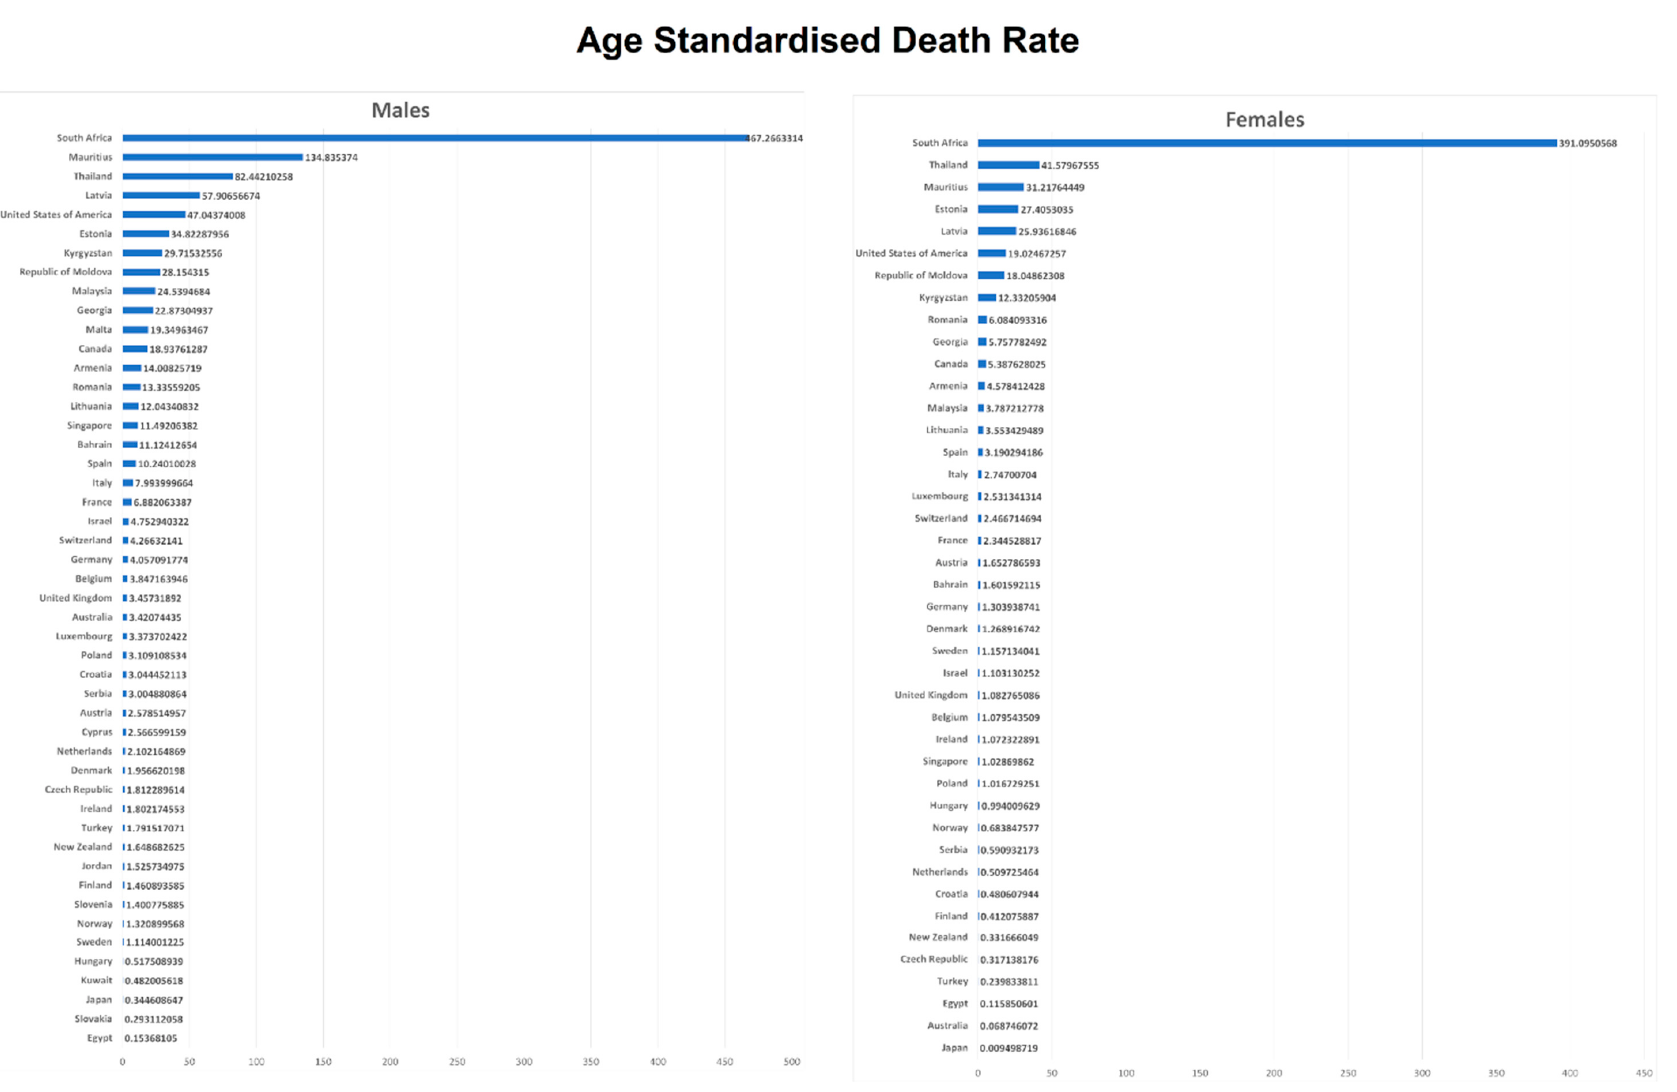
Figure 2. Age-standardized death rate in males and females,